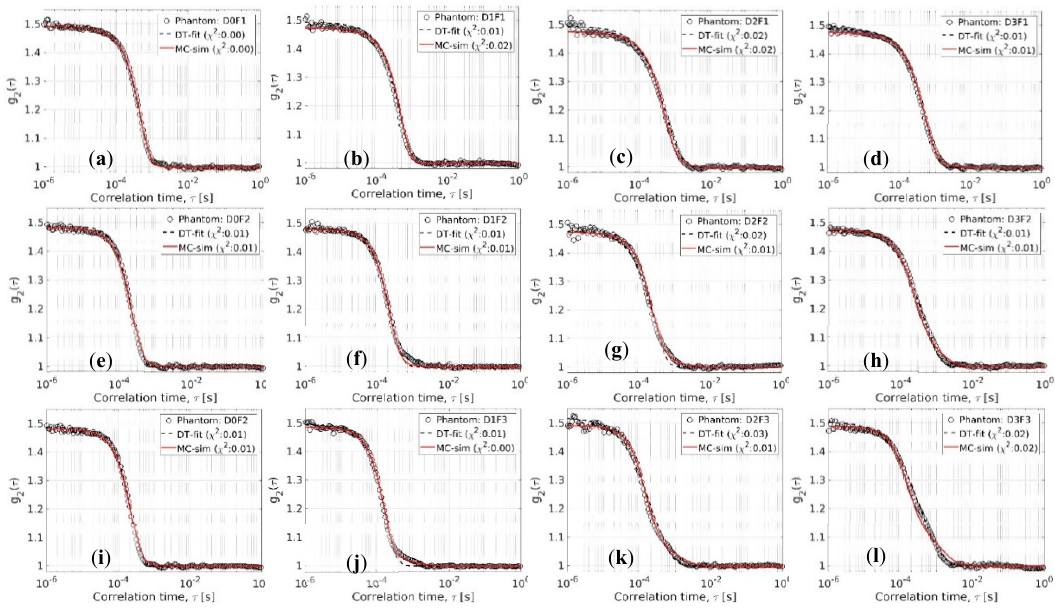
Figure 12. Comparisons of experimentally measured data (circles), di ff usion theory-based fits (dashed line) and MC predictions (solid line) for the 12 phantoms with actively pumped. ( a – d ) show these data when flow rate was F 1 = 1.44 mL / h for depths D 0 – D 3 . (( e – h ) show the same sequence of depths at flow rate F 2 = 3.6 mL / h and ( i – l ) for flow rate F 3 = 5.76 mL /